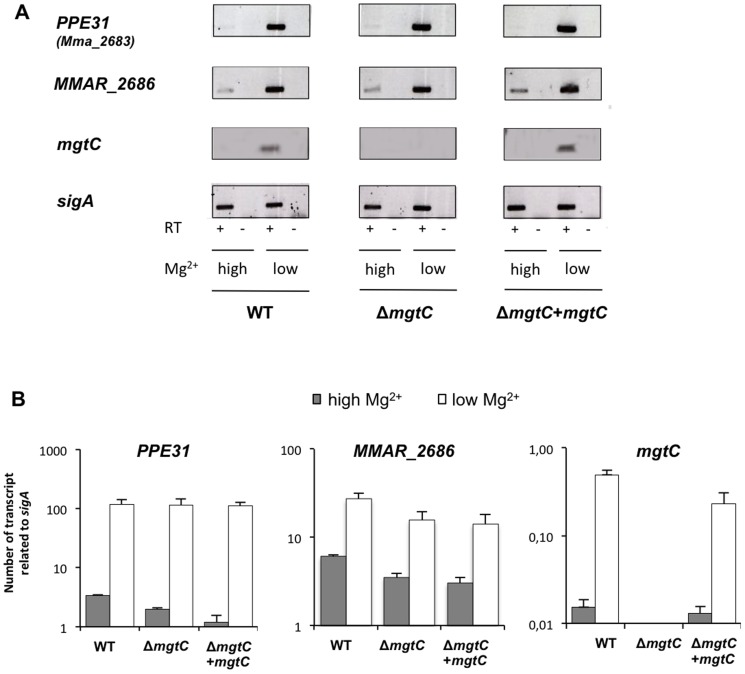
Expression of Mma mgtC and upstream genes in high Mg2+ and low Mg2+ conditions.(A) RT-PCR experiment on RNA isolated from M. marinum strains grown in high or low Mg2+ with primers specific for mgtC, MMAR_2686, MMAR_2683 (PPE31) and sigA. Experiment was carried out with wild-type strain, mgtC mutant strain and complemented strain. Controls where reverse transcriptase was omitted (indicated by RT -) are done to verify the absence of genomic DNA contamination in the RNA sample. The sigA gene is used as control. (B) Quantification of mgtC, MMAR_2686 and MMAR_2683 RNA by Q-RT-PCR experiment using RNA isolated from M. marinum strains grown in high or low Mg2+. The sigma factor sigA was used as an internal standard. Results are expressed as means+standard deviations (SD) from a representative experiment performed in triplicate.